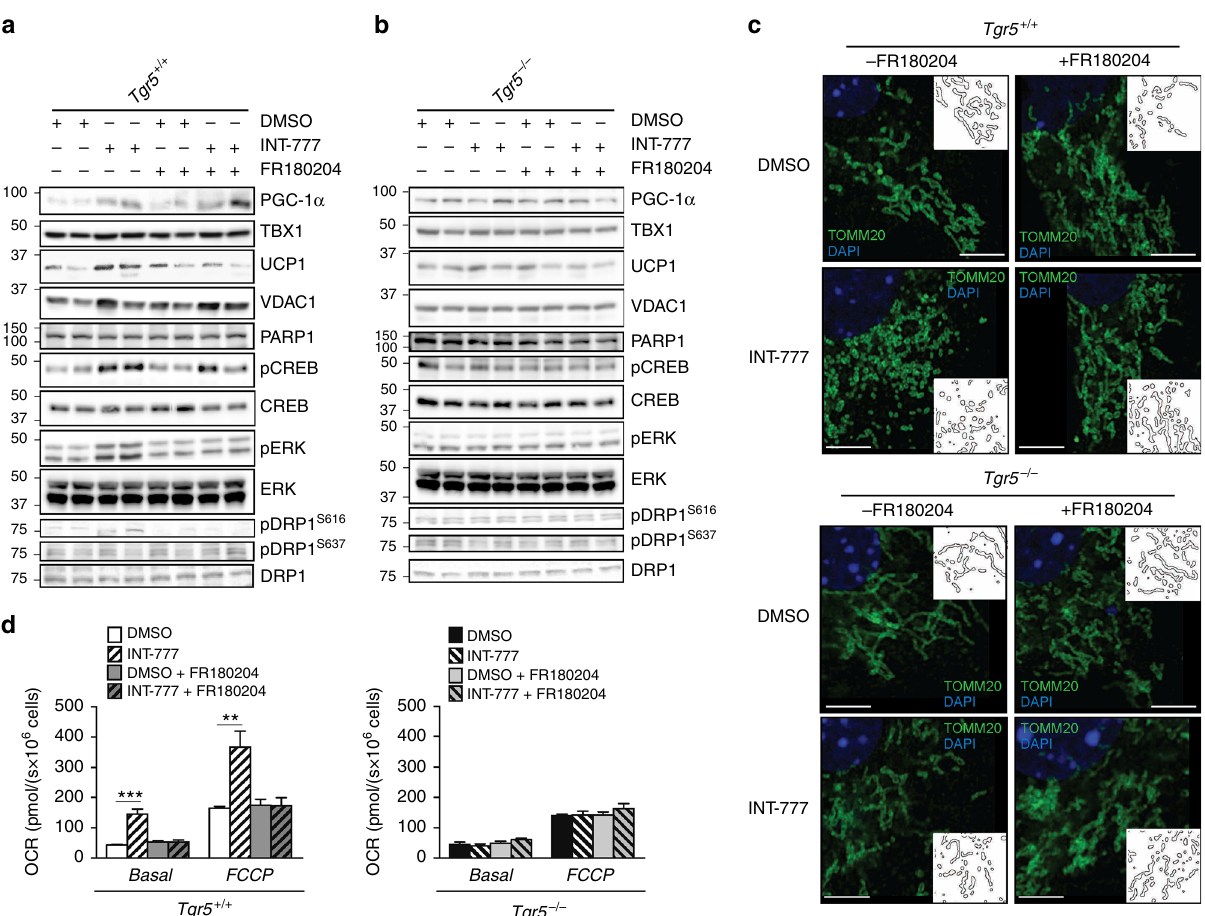
Fig. 7 ERK activation is required for TGR5-mediated mitochondrial fi ssion. a , b Representative ( n = 6 per group) western blots of PGC-1 α , the mitochondrial marker VDAC1, and beiging markers TBX1 and UCP1, and TGR5 downstream targets (phospho proteins) with their relative controls (CREB, ERK and DRP1) from differentiated adipocytes derived from the stromal vascular fraction (SVF) of TGR5 wild-type ( Tgr5 + / + ) ( a ) and germline TGR5 knockout ( Tgr5 − / − ) ( b ) mice. PARP1 was used as loading control. Cells were stimulated with the TGR5 agonist INT-777 or vehicle (DMSO) in the presence or absence of the selective ERK inhibitor FR180204. n = 6. c Representative ( n = 6 per group) images of TOMM20 immuno fl uorescence (in green) on preadipocytes derived from the stromal vascular fraction (SVF) of TGR5 wild-type ( Tgr5 + / + ) and germline TGR5 knockout ( Tgr5 − / − ) mice. Cells were stimulated as described in a and b . Nuclei were stained with DAPI (in blue). Scale bars = 10 μ m. Insets show a reconstruction of the mitochondrial network. n = 6. d Oxygen consumption rate (OCR) of the cells described in a and b . Cellular respiration was measured in basal condition (Basal) and at maximal respiration (FCCP). Results represent mean ± SEM. ** P ≤ 0.01 and *** P ≤ 0.001 vs. Tgr5 + / + cells by one-way ANOVA followed by Bonferroni post hoc test. Uncropped